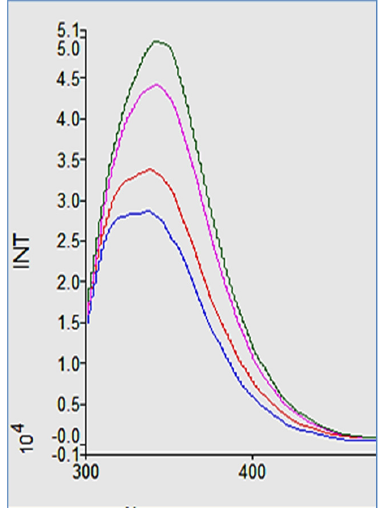
Figure 6. Anti-inflammatory activities of light (IDHBH) and dark (DHBH) essential oils Green: BSA; Pink: Dark oil; Red: Light oil; Blue: Ibugesic Ibugesic (+